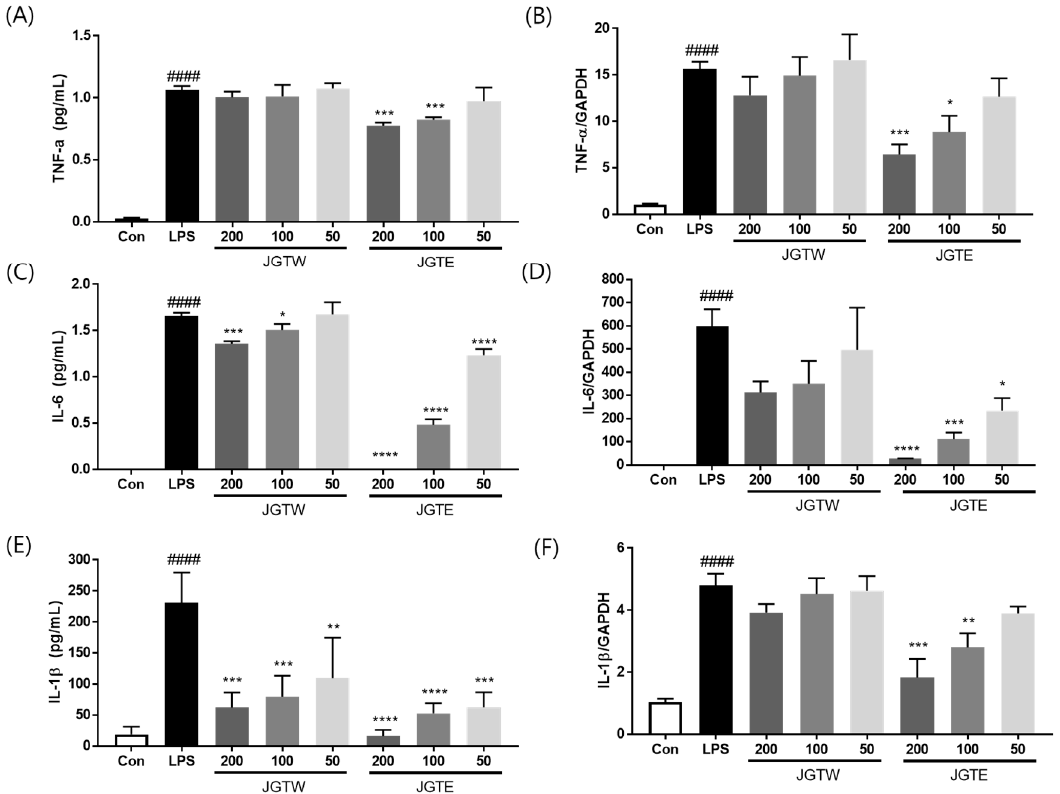
Figure 2. E ff ect of JGTW and JGTE on production of TNF- α , IL-6, and IL-1 β in LPS-stimulated RAW264.7 macrophages by ( A , C , E ) ELISA and ( B , D , F ) real-time PCR. RAW264.7 cells were pre-treated with JGTW or JGTE (50, 100, and 200 µ g / mL) for 2 h, and then stimulated with LPS (0.5 µ g / mL) for 24 h. The values are expressed as the mean ± SD ( n = 3). #### p < 0.0001 vs. vehicle control cells. * p < 0.05, ** p < 0.01, *** p < 0.001, **** p < 0.0001 vs. LPS-induced cells.